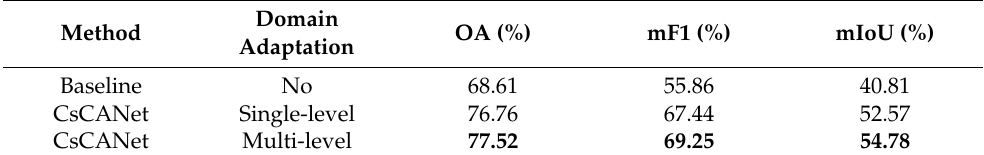
Table 5. Performance comparisons of CsCANet with different domain adaptation frameworks in evaluation metrics. The best results are highlighted in bold.